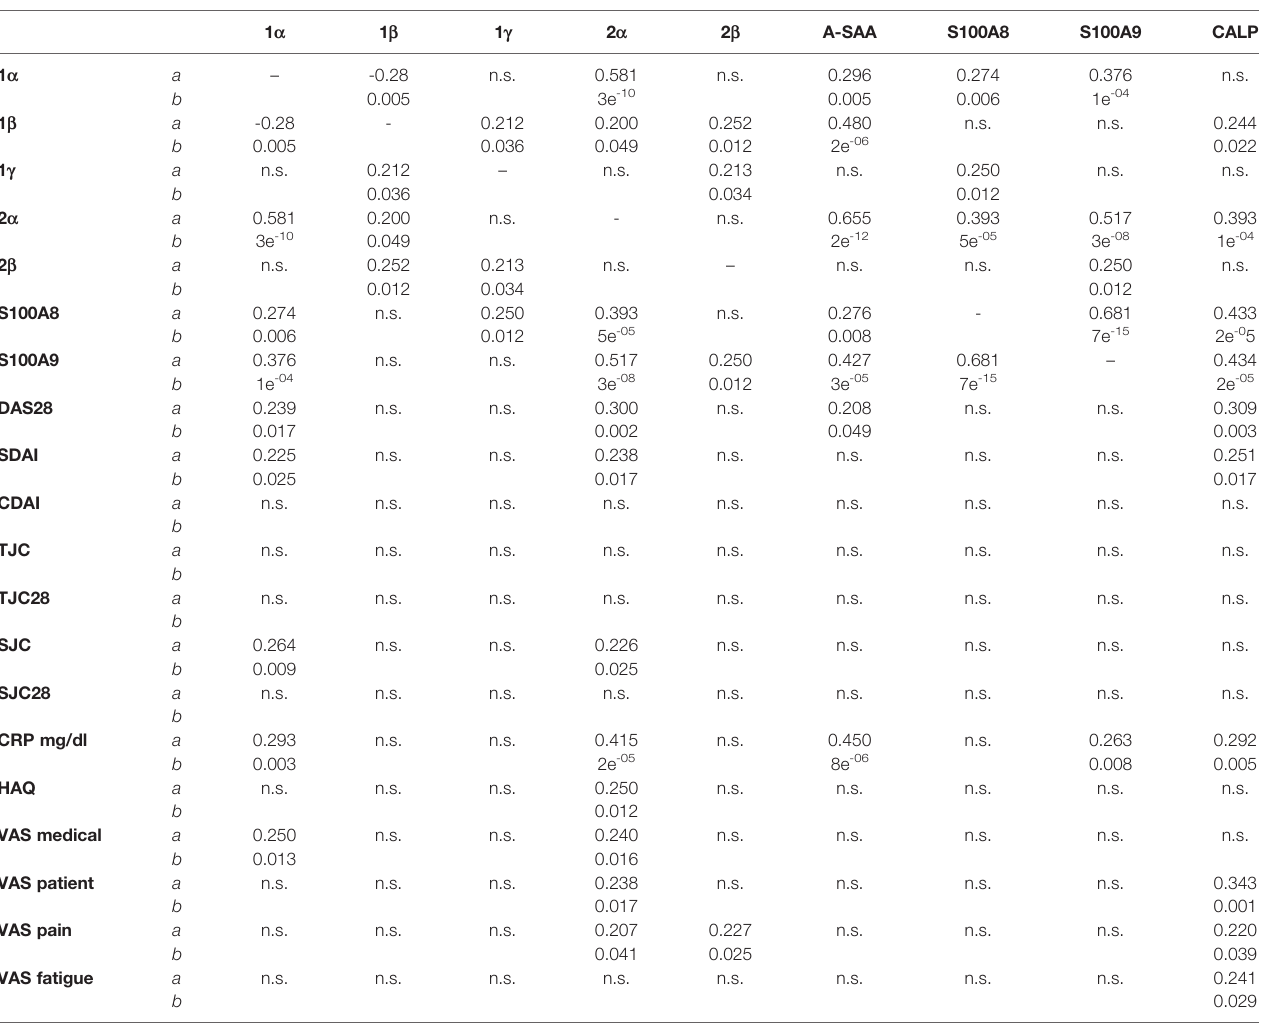
TABLE 2 | Statistical correlation among proteins and clinical